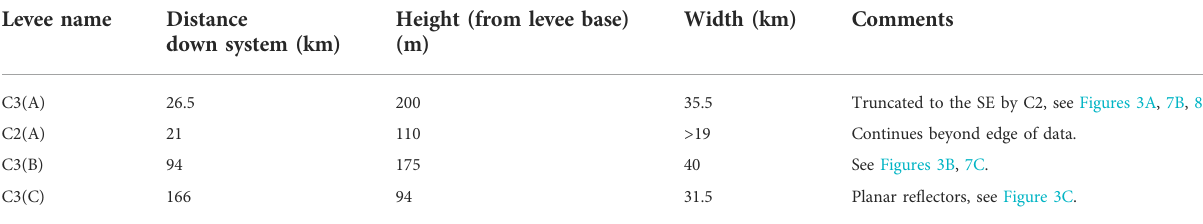
TABLE 2 Dimensions of right-hand external levees in the Greenland